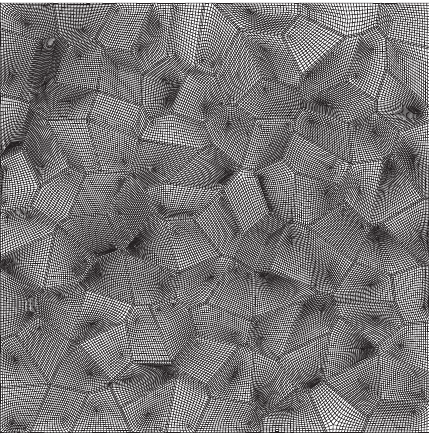
Figure 4. The finite-element model used for the representative volume element (RVE) of the lamellar